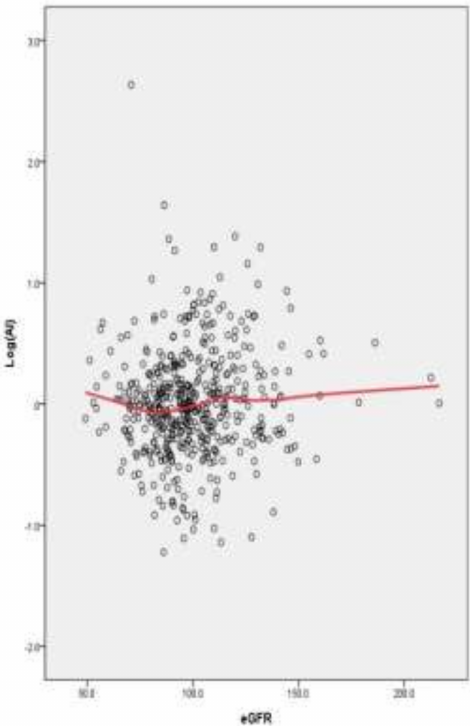
Figure 3. Scatter plot for eGFR and log-transformed Al